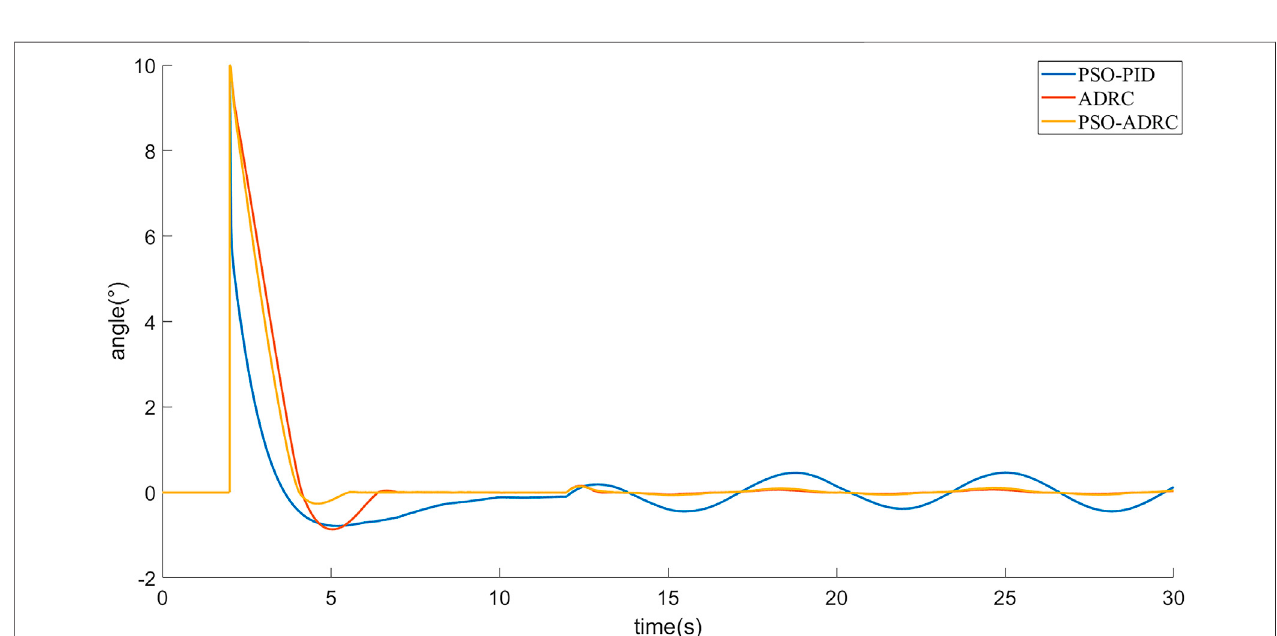
FIGURE 11 | Tracking error under internal